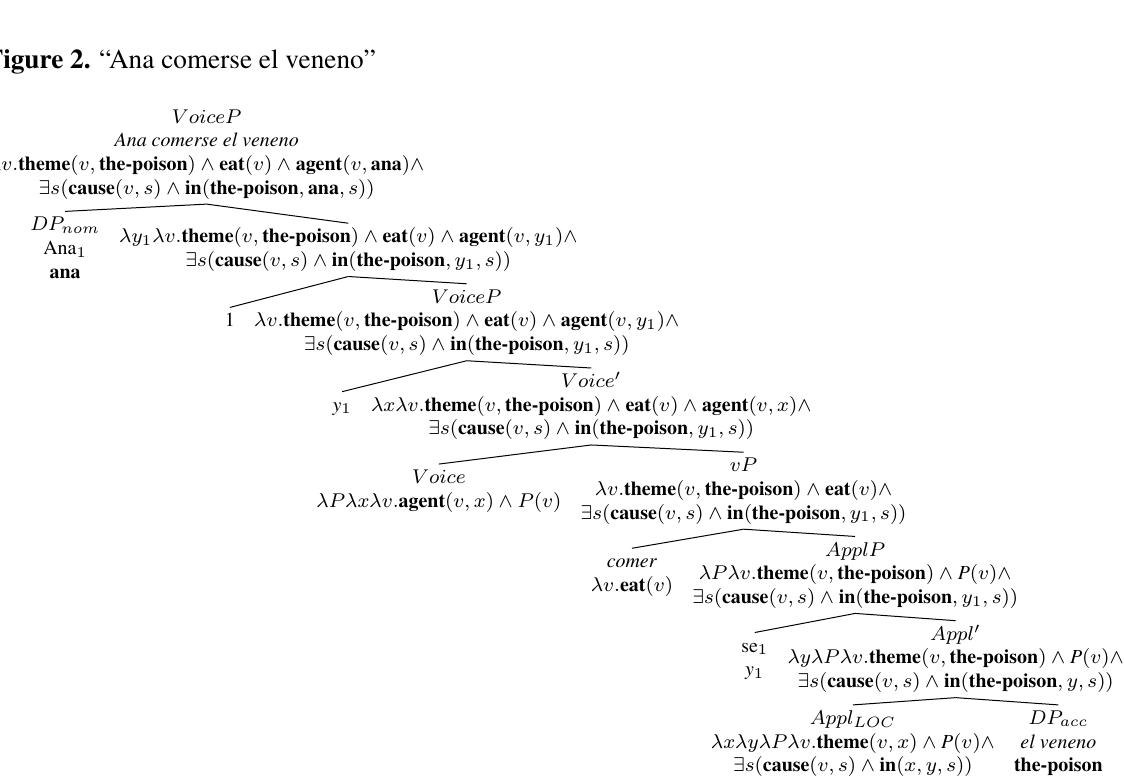
Figure 2. “Ana comerse el veneno” V oiceP Ana comerse el veneno λv. theme ( v, the-poison ) ∧ eat ( v ) ∧ agent ( v, ana ) ∧ ∃ s ( cause ( v,s ) ∧ in ( the-poison , ana ,s